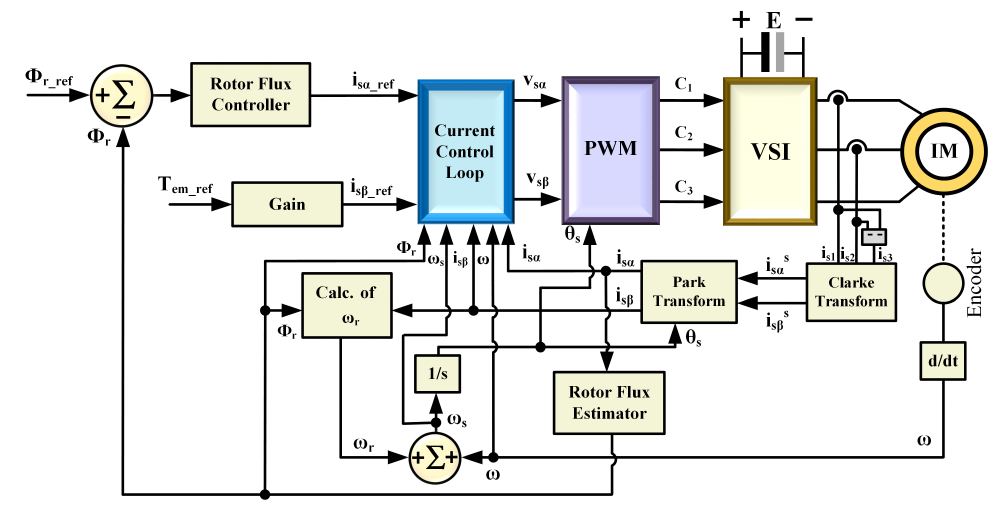
Figure 2. The block diagram of the DRFOC algorithm of an induction